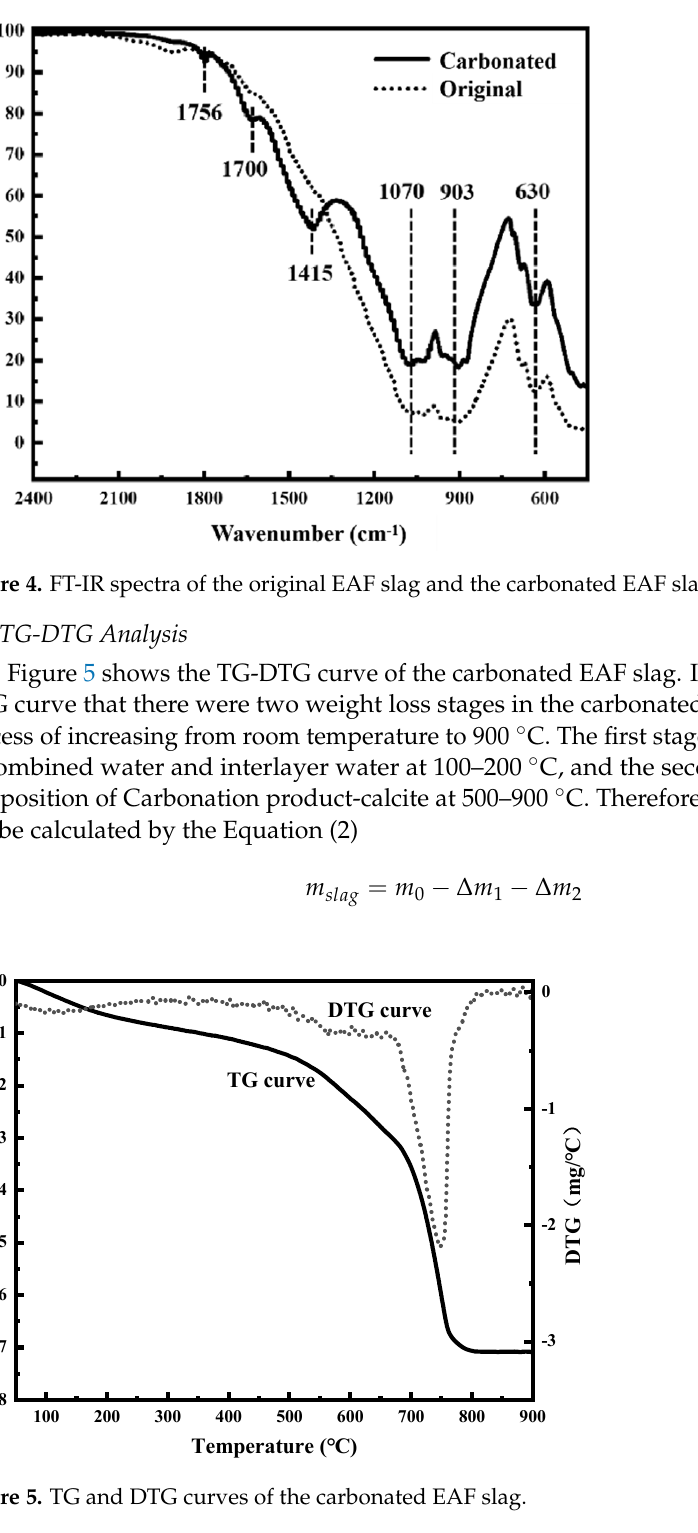
Figure 5. TG and DTG curves of the carbonated EAF slag. 3.5. Effect of Carbonation on Leaching Characteristics of EAF Slag The electrochemical characteristics of the leachate mainly include pH value, redox potential, and conductivity. Continuous monitoring of the electrochemical characteristics